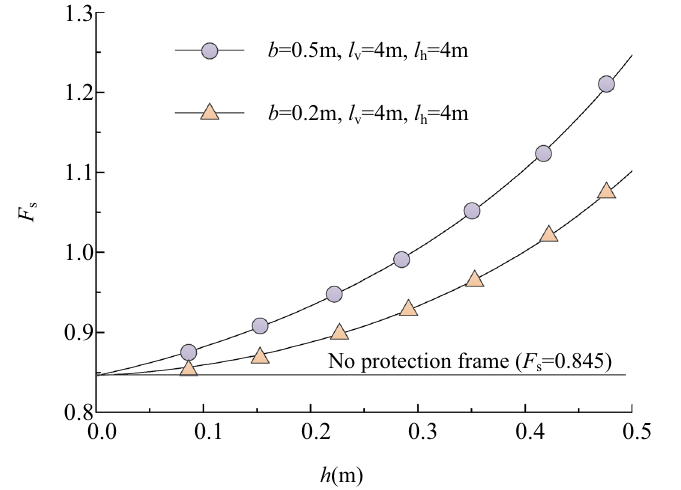
Figure 12. F s change with h (slope ratio = 1.5, z w = 1.2 m).